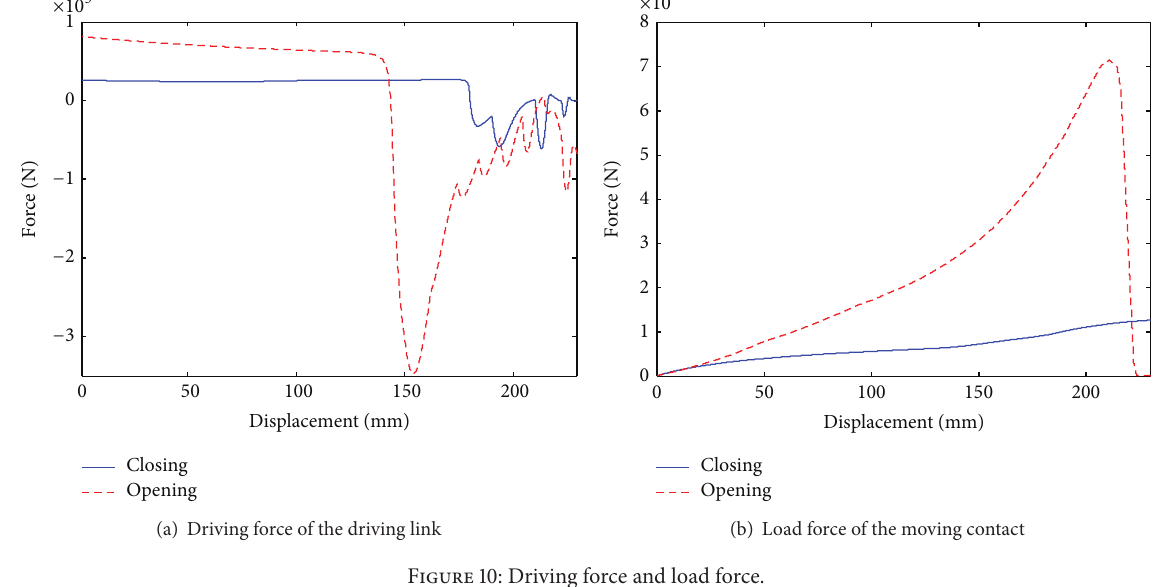
Figure 10: Driving force and load